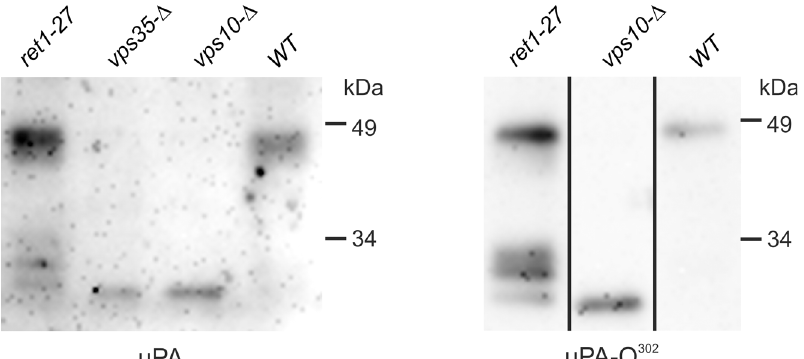
Fig 9. Immunoblot analysis of uPA from culture supernatants. uPA, the strains 64MA70UAL ( ret1-27 ), 64MA70UA-RET ( WT ), 64MA70U-RET- Δ vps10 ( vps10- Δ ), and 64MA70U-RET- Δ vps35 ( vps35- Δ ), expressing the wild-type uPA; uPA-Q 302 , the strains 64MA70QAL ( ret1-27 ), 64MA70QA-RET ( WT ), and 64MA70Q-RET- Δ vps10 ( vps10- Δ ), expressing the unglycosylated uPA-Q 302 mutant protein. Samples with the wild-type uPA were treated with EndoH prior to